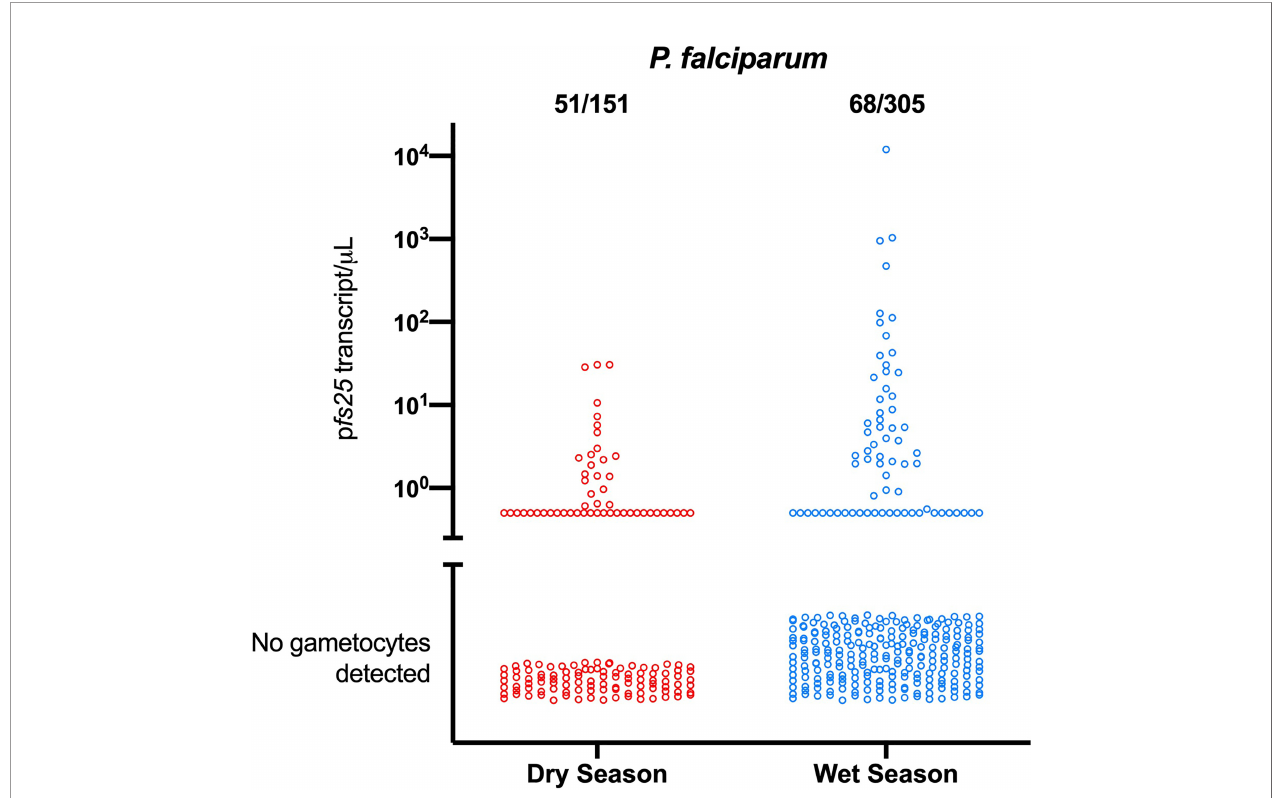
FIGURE 2 | Differences in the proportion of P. falciparum gametocyte-positive infections and gametocyte densities between the dry and the wet season in western Kenya (Oduma et al., 2021). In the wet season, fewer infections carried gametocytes, yet mean gametocyte densities were over 3-fold higher. Mean parasite densities did not change, indicating an increased investment in